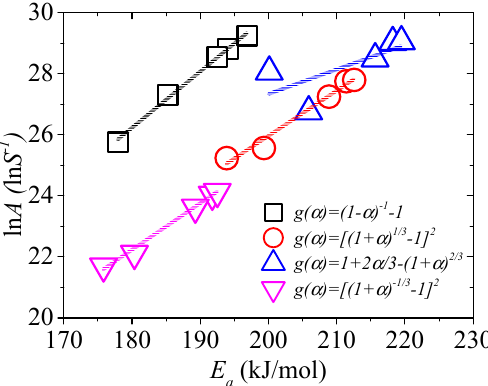
Figure 2. The plot of ln A versus E a .